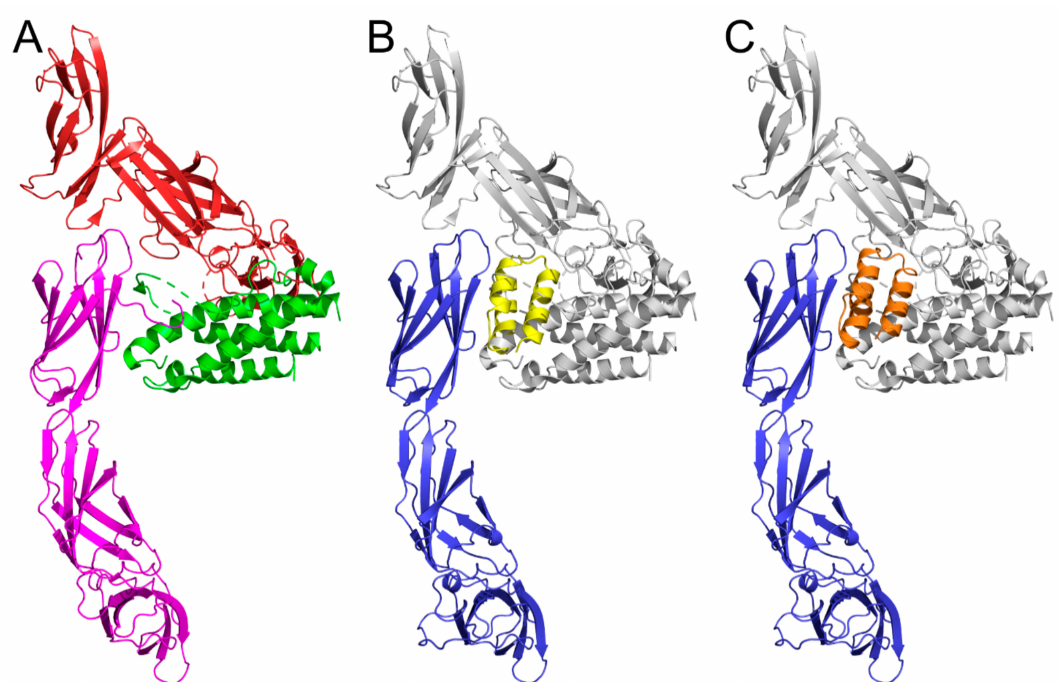
Figure 7. Predicted binding mode of ABD variants to the IL-23R. ( A ) The crystal structure of human IL-23 / IL-23R complex (pdb id 5mzv) [29] showing the IL-23R in magenta, the IL-23 subunit p19 in green, and the IL-12 subunit p40 of IL23 in red. ( B ) The most probable predicted binding mode of the REX115 (yellow) to the murine IL-23 model (blue) overlapping with the position of IL-23 (grey) from the human IL-23 / IL-23R complex. ( C ) The most probable predicted binding mode of the REX125 (orange) to the murine IL-23 model